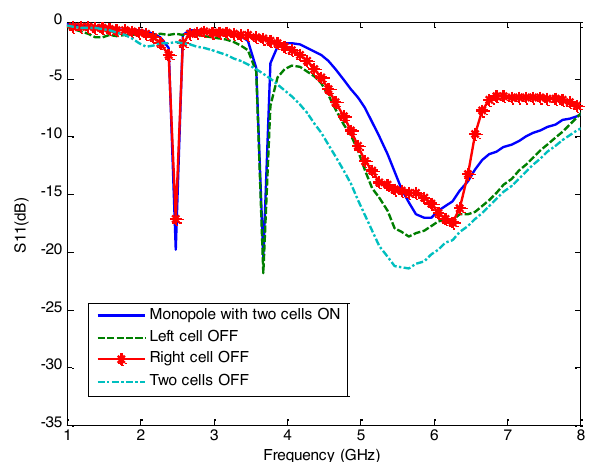
Fig.14 Measured the reflection coefficient of four cases of antenna